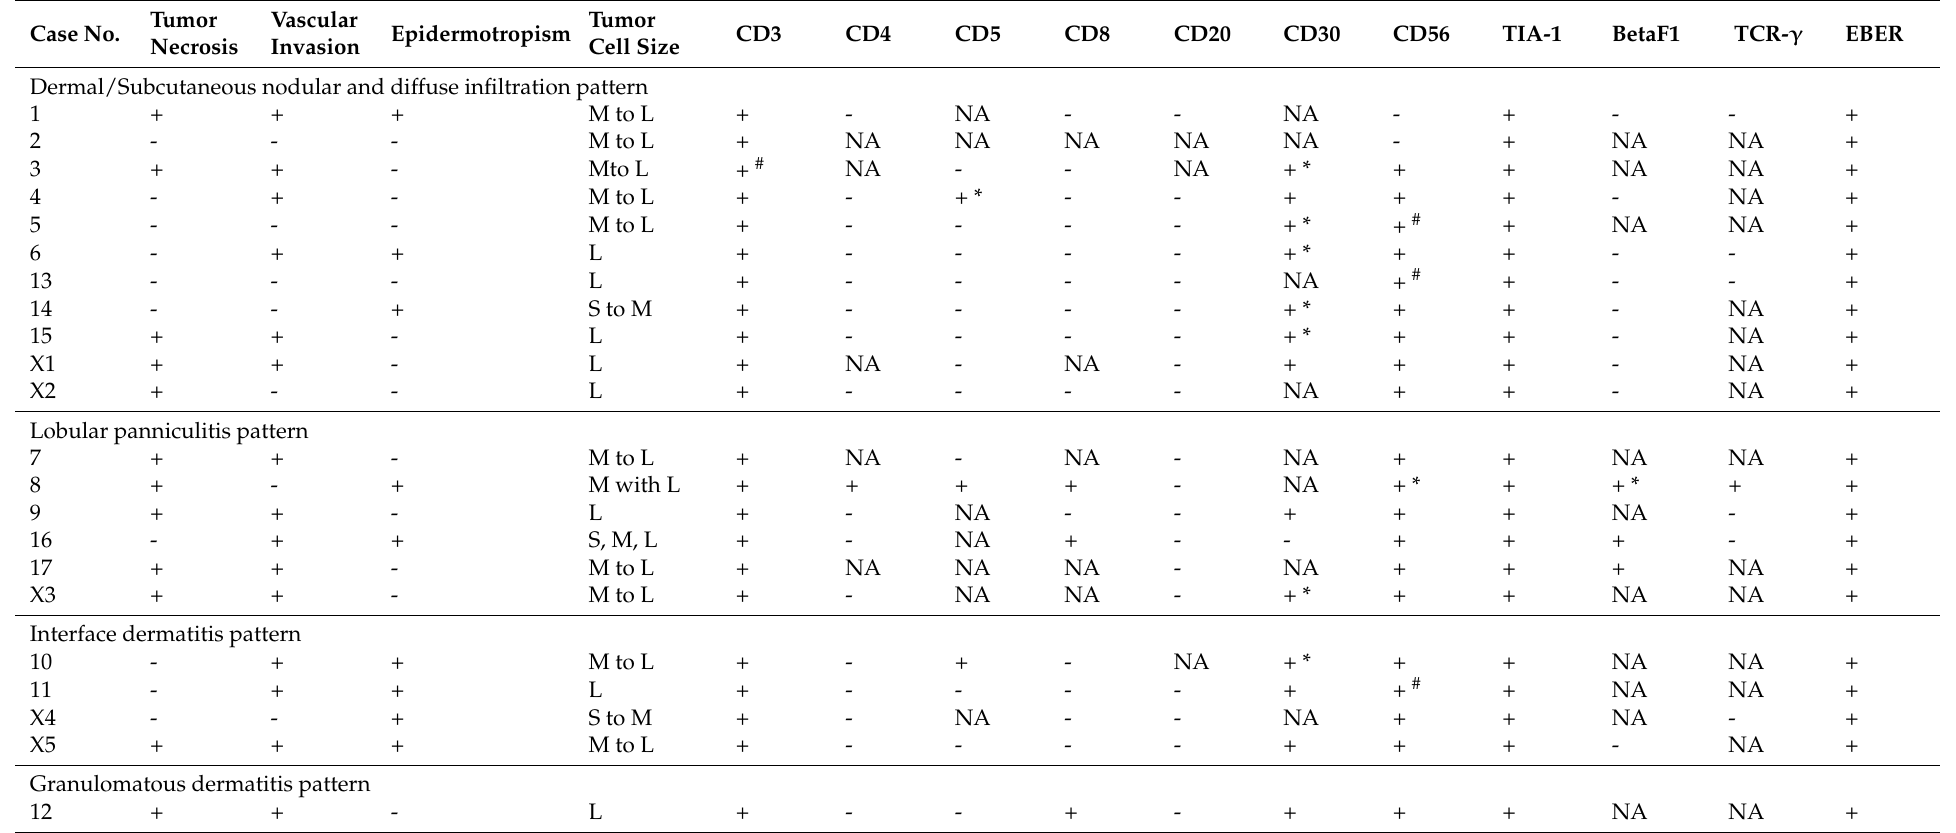
Table 3. Histopathological patterns and